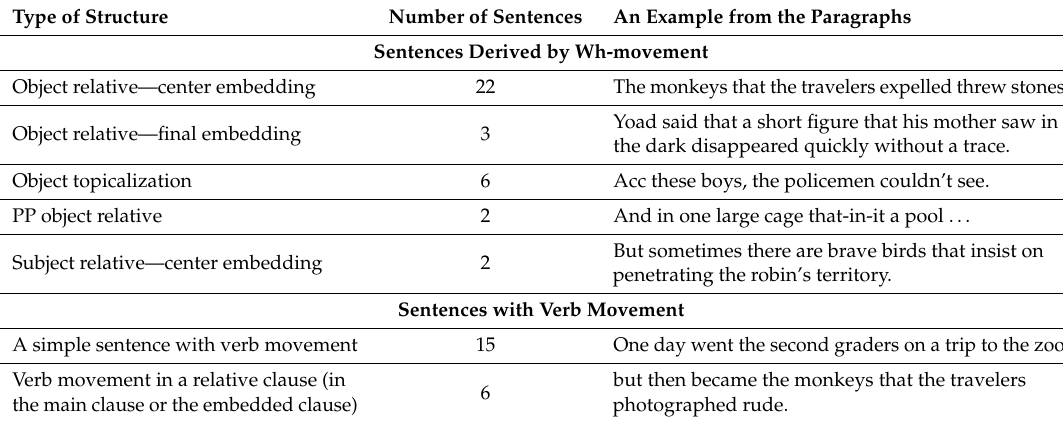
Table A3. The types of structures included in the 6 paragraphs with movement, the number of sentences of each type, and